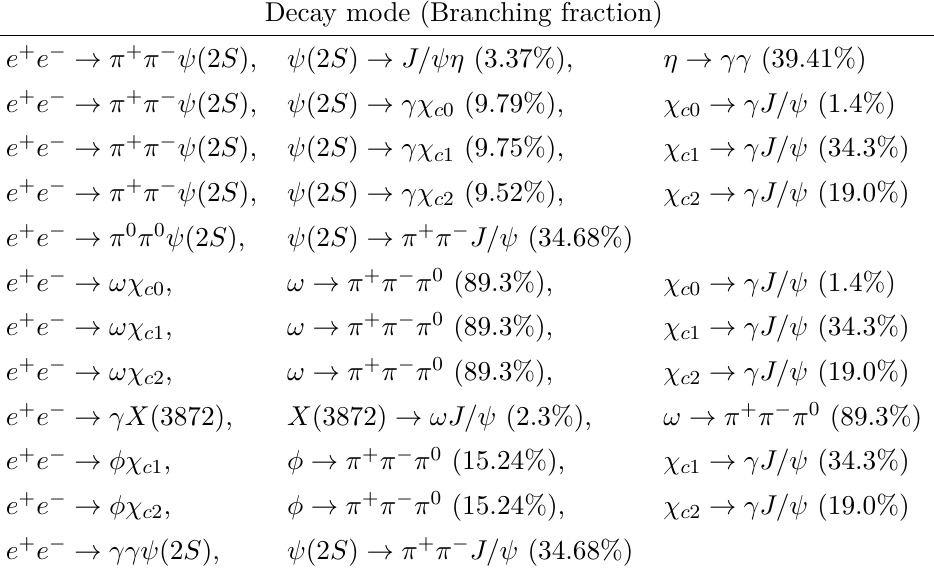
Table 1. The background processes (all J/ψ mesons decay into ‘ + ‘ −